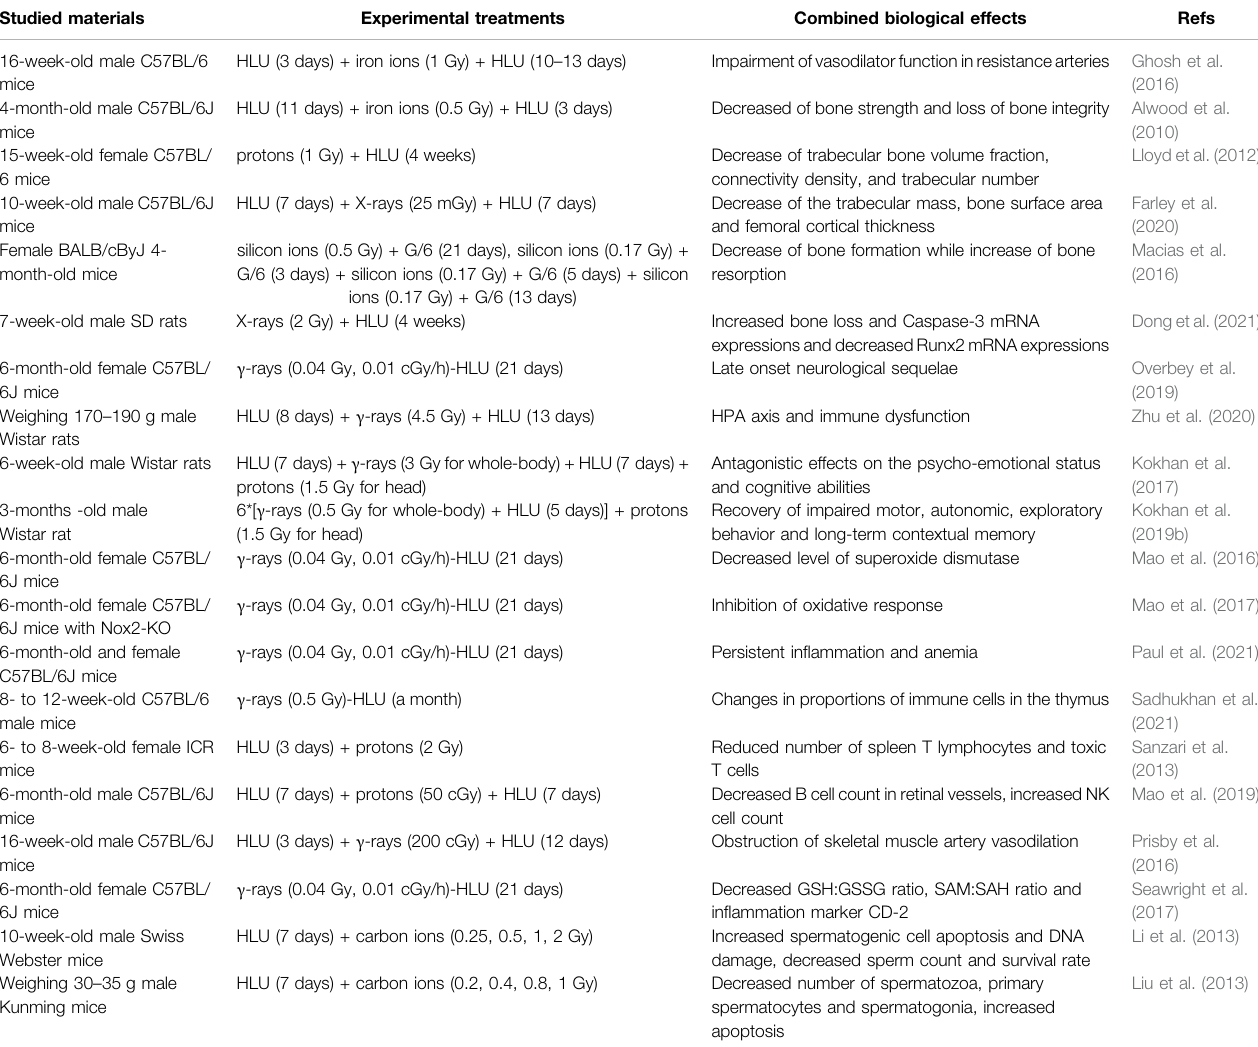
TABLE 1 | Studies reporting the combined effects of irradiation and microgravity in